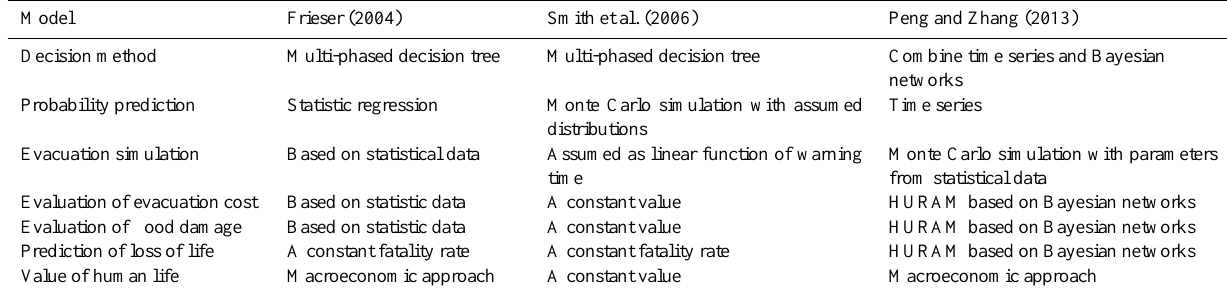
Table 4. Comparison of decision-making methods for dam break